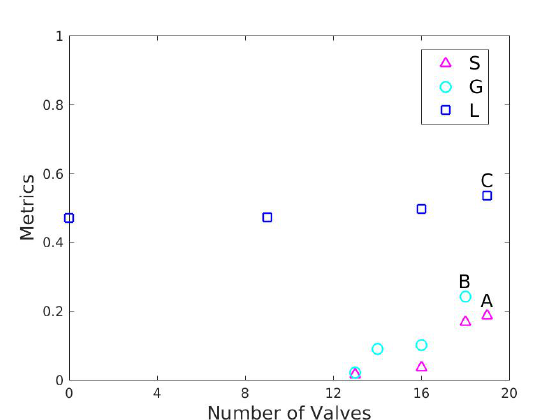
Figure 5. Pareto front of solutions for the three-reservoir network (TRN) obtained with the three studied performance indices (PIs). Legend: S: Standard deviation, G: Gini coefficient, L: Loss of resilience.